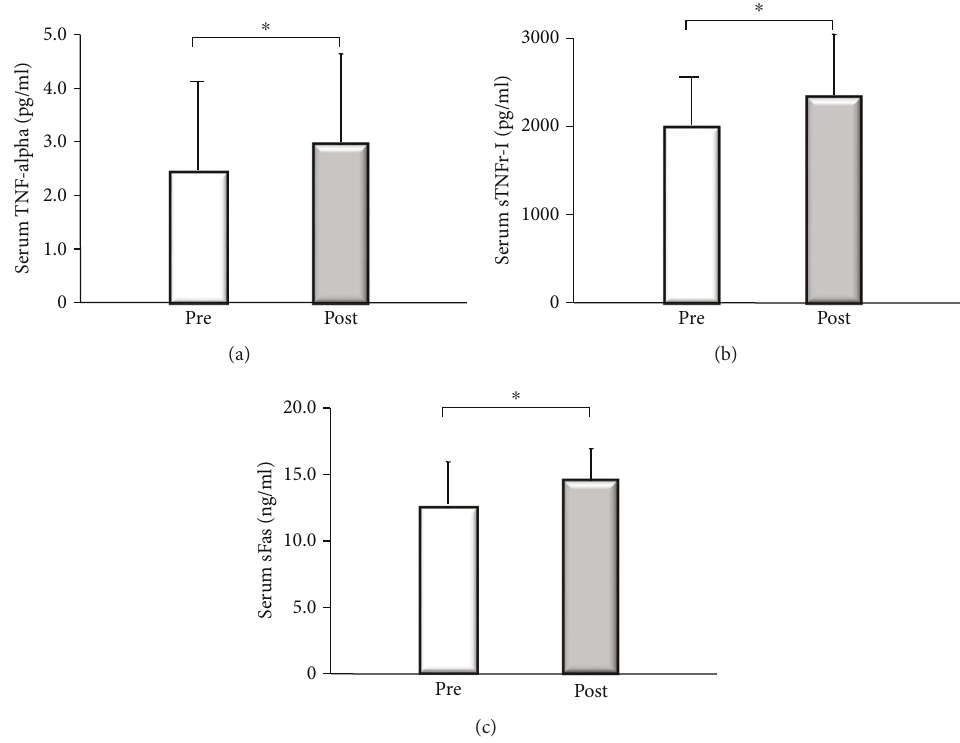
Figure 7: Serum cytokine levels before and 4 weeks after partial splenic embolization (PSE). Upper left: the serum level of TNF-alpha showed a signi fi cant increase after PSE compared to before PSE (from 2.4 ± 2pg/ml to 3.0 ± 2 pg/ml: ∗ p = 0 0077 , by Wilcoxon ’ s test). Upper right: the serum level of soluble TNF-alpha receptor I was also increased signi fi cantly after PSE compared to before PSE (from 1997.3 ± 603 pg/ml (sTNFr-I) to 2392.0 ± 701pg/ml: ∗ p = 0 0022 , by Wilcoxon ’ s test). Furthermore, the serum level of soluble Fas was signi fi cantly higher after PSE than before PSE (from 11.8 ± 3 ng/ml to 13.7 ± 3 ng/ml: ∗ p = 0 0076 , by Wilcoxon ’ s